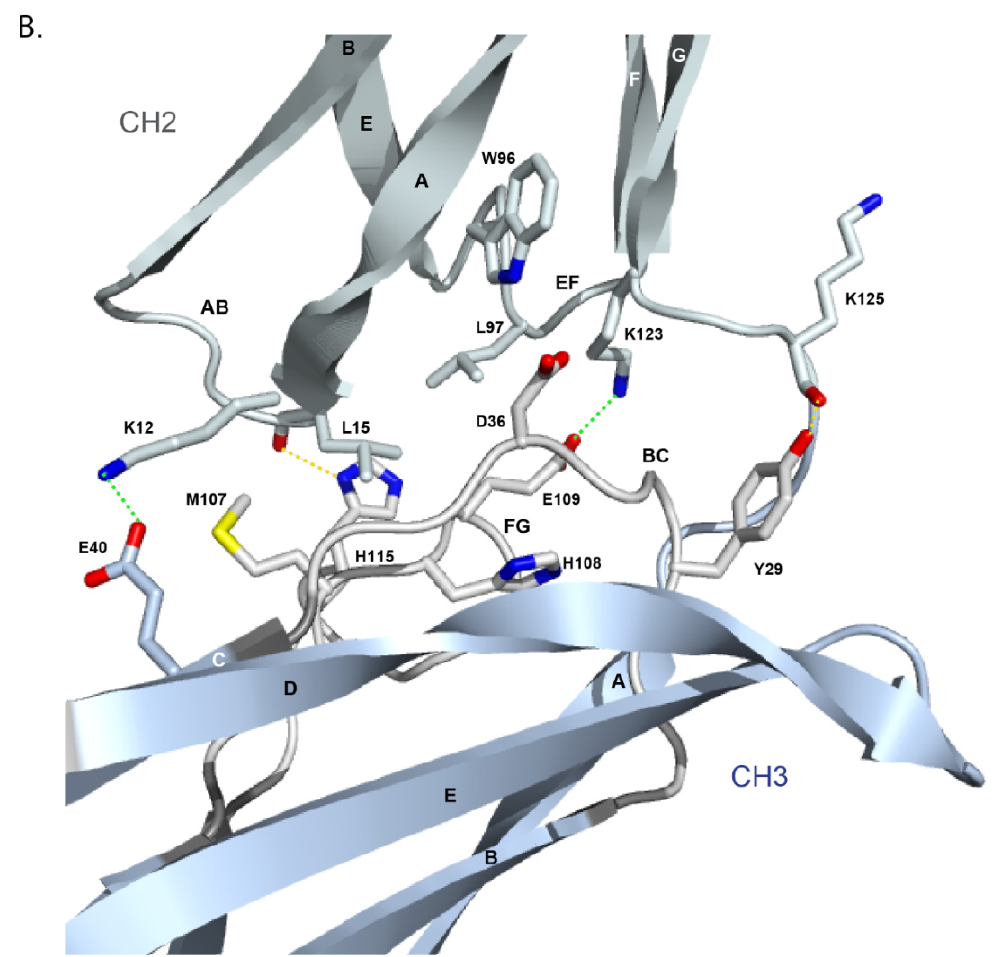
Figure 38. Contact analysis and ball-and-socket interface between Homo sapiens IGHG1 CH2 and CH3 [94]. ( A ) Contact analysis between the CH2 and CH3 domains of the Fc gamma1 (from IMGT / 3Dstructure-DB, 3ave_A). The amino acids of the CH3 BC and FG loops (left column) and those of the CH2 G strand (right column) are shown in rectangles. CH2 96 and 97 correspond to the EF turn whereas other positions are from the A strand or AB turn. Arrows indicates the two hydrogen bonds (orange on line) and the two salt bridges (green online) mentioned in the text [312]. ( B ) The ball-and-socket-joint of the IGHG1 CH2-CH3 interface [312] is shown using the IMGT numbering, with the ball (L15) and the socket (M107, H108, E109 and H115). The interface is stabilized by two hydrogen bonds involving on CH2, L15 (O) and K125 (O) that bind on CH3, H115 (ND1) and Y29 (OH), respectively, and by two salt bridges involving on CH2, K12 (A strand) and K123 (G strand) that interact on CH3 with E40 (C strand) and E109 (FG loop), respectively. The identifier of the gamma1 chain to which the CH2 and CH3 domains belong is 3ave_A (IMGT ® http: // www.imgt.org, IMGT / 3Dstructure-DB). (With permission from M-P. Lefranc and G. Lefranc, LIGM, Founders and Authors of IMGT ® , the international ImMunoGeneTics information system ® , http: // www.imgt.org). The H-gamma1 chains may express four G1m alleles (combinations of G1m allotypes): G1m3, G1m3,1, G1m17,1, and G1m17,1,2 (and in Negroid populations three additional G1m alleles, Gm17,1,27, Gm17,1,28 and Gm17,1,27,28) [83]. The correspondence between the G1m alleles and IGHG1 alleles is shown in Table